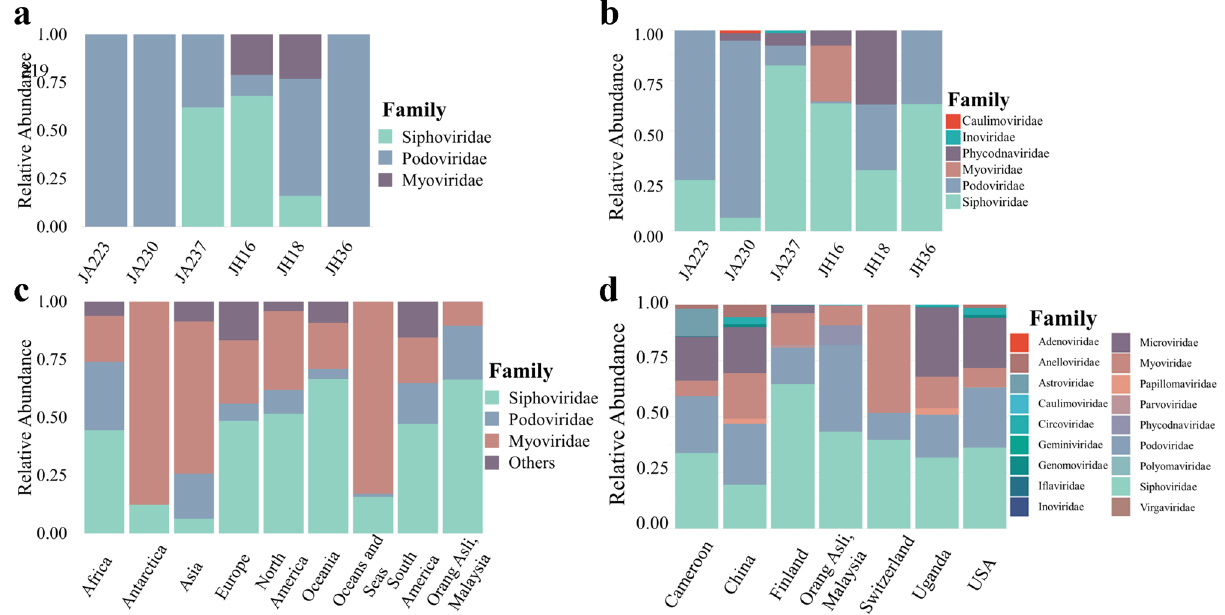
Figure 1. Relative abundance plot of viral families. ( a , b ) Six individuals, three from Jakun Orang Asli (JA223, JA230, JA237) and three from Jehai Orang Asli (JH16, JH18, JH36), taxonomy assigned by vConTACT2 and GDVT respectively. ( c ) Caudovirales order among Orang Asli, Malaysia, (n = 6) against different continents in isolates from NCBI Virus Database, Africa (n = 484), Antartica (n = 73), Asia (n = 8322), Europe (n = 6815), North America (n = 33,966), Oceania (n = 241), Oceans and Seas (n = 1052), South America (n = 161). ( d ) Orang Asli from Malaysia against Human Gut Virome Database separated based on country of origin,